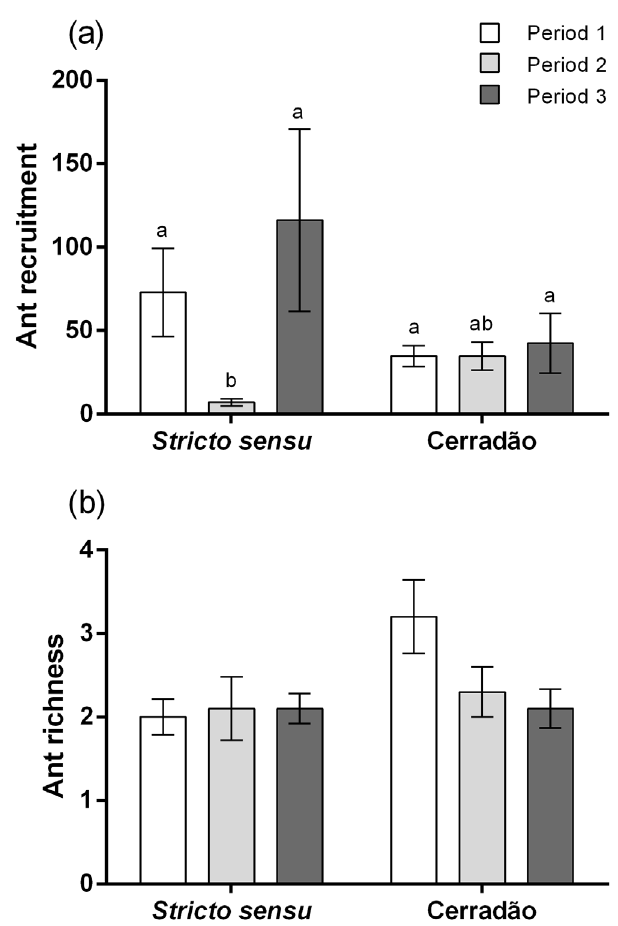
Fig 4 . The effects of cerrado area ( stricto sensu and cerradão) and observation period (period 1 = 8:00 to 10:00; period 2 = 12:00 to 14:00; period 3 = 16:00 to 18:00) on ant recruitment (a) and richness (b). In (a), the linear mixed models revealed differences in ant recruitment considering the observation period, where recruitment was particularly low during period 2 of cerrado stricto sensu . Ant richness has not varied significantly in any treatment (b). Bars represent means, and all variability measures represent the standard error of the